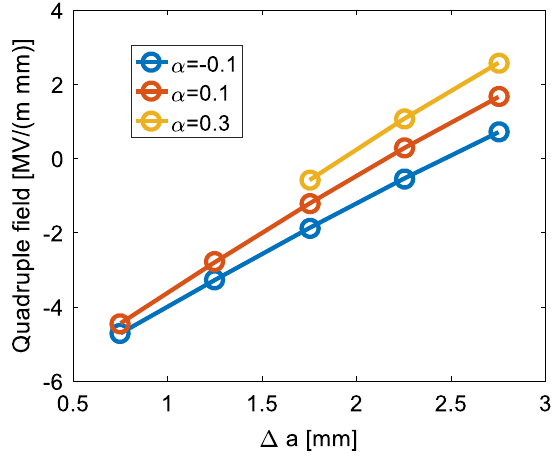
FIG. 20. Amplitude of quadruple components versus iris geometry.